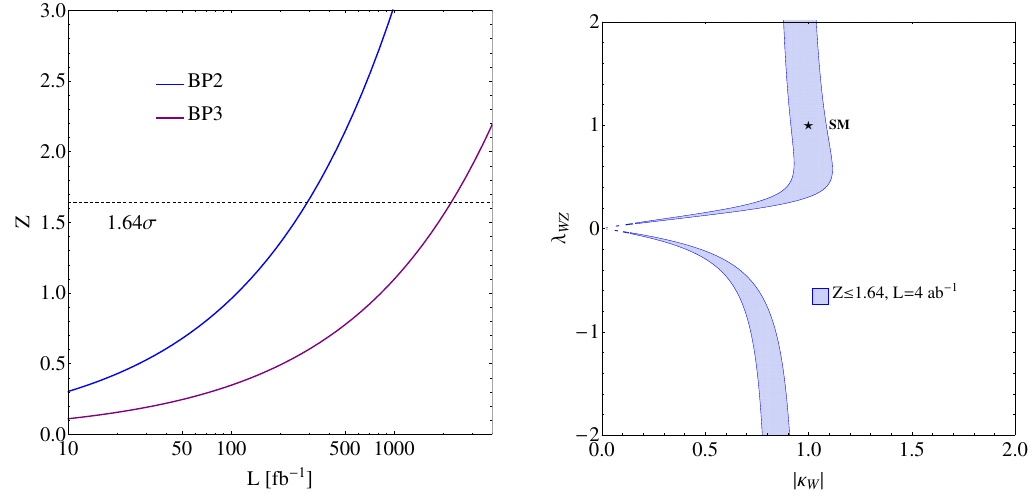
Figure 4 . Power to discriminate (cid:21) WZ in the jj‘ (cid:6) bb channel at the 500-GeV ILC with beam polarization P ( e (cid:0) ; e + ) = ( SM scenario (BP1). Right: region in the integrated luminosity of 4 ab (cid:0) 1